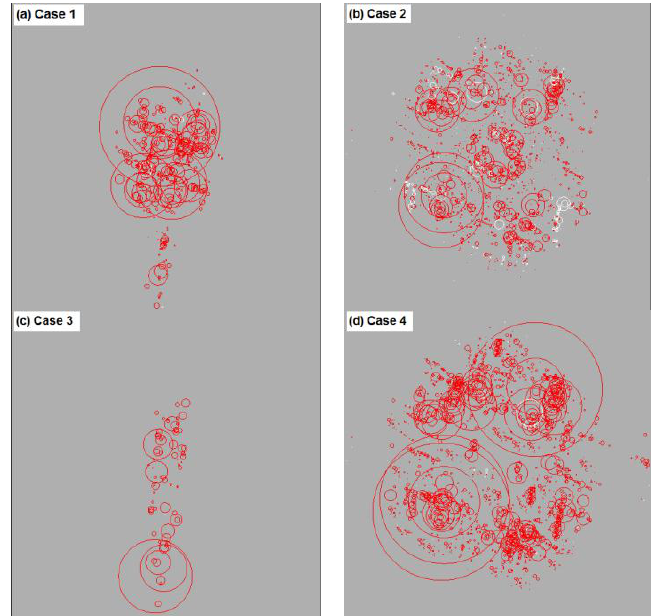
Figure 4. The synthetic microseismic events at different injection rate for the four studied variable injection rate cases. The synthetic microseismic events are colored by red when elements are compressive-shear failure and white when tensile failure. The size of circle indicates magnitude of microseismic events (Note that: element whose failure energy is relative small, microseismic sign is not brought